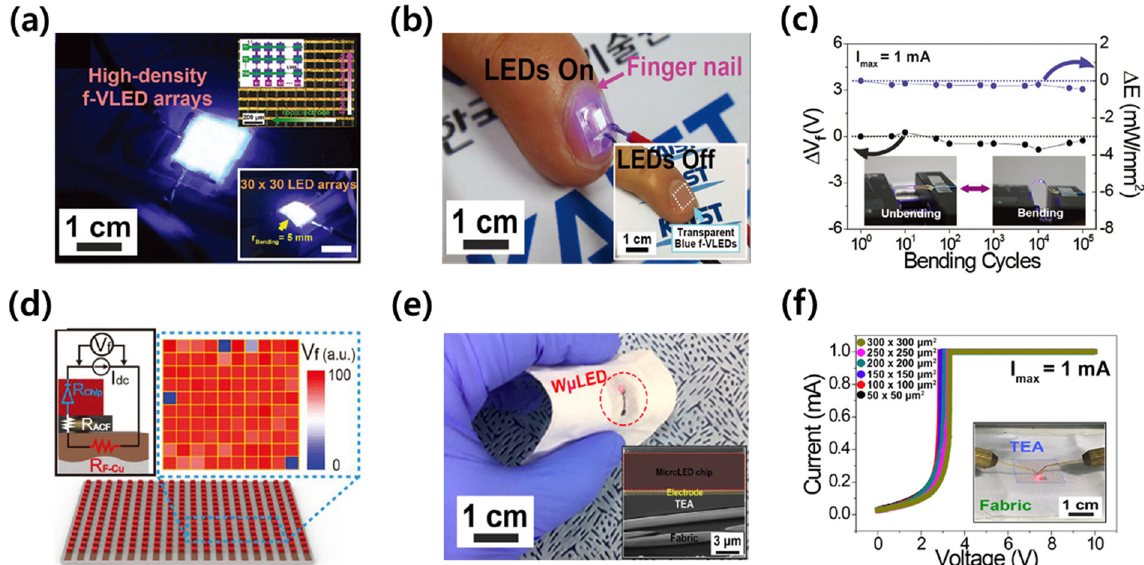
Figure 6. ( a ) Photograph of monolithic flexible blue μ LEDs with 30 × 30 array. The top inset is a magnified optical image of a passive-matrix μ LED array. Scale bar: 1 cm. The bottom inset is an optical image of monolithic blue μ LEDs in a bent state. ( b ) Transparent flexible blue μ LEDs on human fingernail. The inset image shows fingernail-attached transparent device in off-state. ( c ) Fatigue test results of monolithic flexible μ LEDs during 10 6 bending/unbending cycles. Reproduced with permission [31]. Copyright 2018, Wiley-VCH. ( d ) Normalized forward voltage of 50 × 50 μ LED arrays with flash-induced Cu electrodes. Reproduced with permission [35]. Copyright 2021, Wiley-VCH. ( e ) Optical image of wearable red μ LED on fabric substrate. The inset is a cross-sectional SEM image of wearable μ LED. ( f ) I-V characteristics of wearable μ LEDs with various size. Reproduced with permission [34]. Copyright 2019, Elsevier.